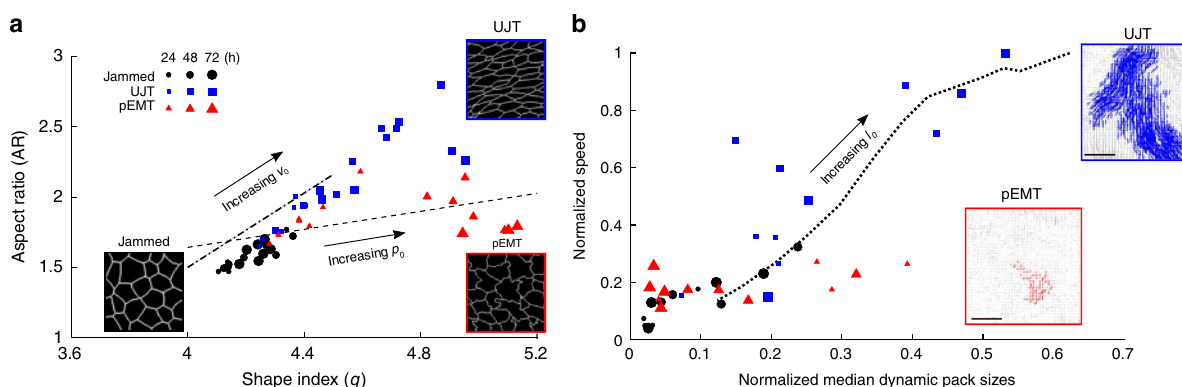
Fig. 5 In theory and experiment, cell shape and collective dynamics discriminate UJT from pEMT. The dynamic vertex model (DVM) attributes the effects of pEMT mainly to diminished edge tension but attributes those of UJT mainly to augmented cellular propulsion. a DVM predicts that during UJT versus pEMT two different metrics of cell shape diverge; aspect ratio (AR) emphasizes elongation whereas shape index q emphasizes perimeter ( q = perimeter/(area 1/2 )). Increasing p 0 (- - -) moderately increases AR but substantially increases q , resulting in somewhat elongated cells with tortuous edges. By contrast, increasing v 0 ( _._._ ) substantially increases AR but minimally increases q , resulting in elongated cells with straight edges. Measurements of AR and q from cells undergoing UJT (blue squares) or pEMT (red triangles) are consistent with those predictions. Insets show traced cell edges from representative images of cells in each state. During pEMT edge tension decreases as junctional adhesion decreases, and as cells elongate q increases more quickly than AR. Cell – cell junctions become increasingly tortuous and slack. During UJT, by contrast, edge tension increases as cellular propulsion v 0 increases, AR and q increase in tandem, and cells elongate. Cell – cell junctions remain straight and taut. Theory and experimental data, taken together, suggest that layer fl uidization by means of UJT versus pEMT follow divergent pathways. b DVM predicts that median pack size and average cell speed will, as persistence length l 0 ( … ) increases, positively scale together. The time courses of median pack size and speed from jammed cells (black circles) or those undergoing pEMT (red triangles) did not follow this relationship. However, the time evolution of median pack size and speed from cells undergoing UJT (blue squares) are consistent with these predictions. During UJT, cellular cooperativity emerges and cells are able to move quickly in locally coordinated groups. Pack sizes, for both experimental and simulation data, were scaled by the size of the system, while cell speeds were scaled by the global maximum. Insets show representative dynamic packs from cells undergoing pEMT or UJT (scale bar: 100 µ m). DVM simulation and experimental data, taken together, thus provide a physical picture of two distinct mechanisms of transition of a cellular collective from a solid-like to a fl uid-like